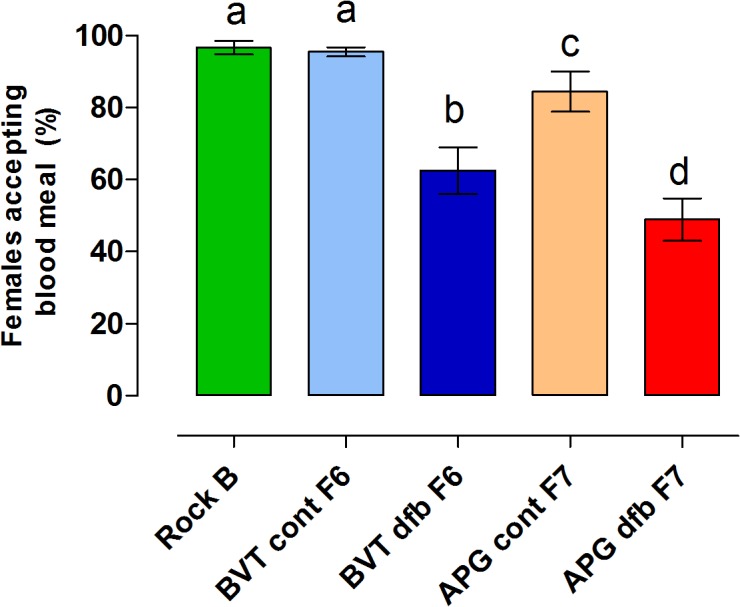
Rate of bloodmeal acceptance for females from the Rockefeller strain (Rock), selected (dfb), or control (cont) groups from Boa Vista (BVT) and Aparecida de Goiânia (APG).Different letters above the columns indicate significant differences among groups (χ2; P < 0.05).